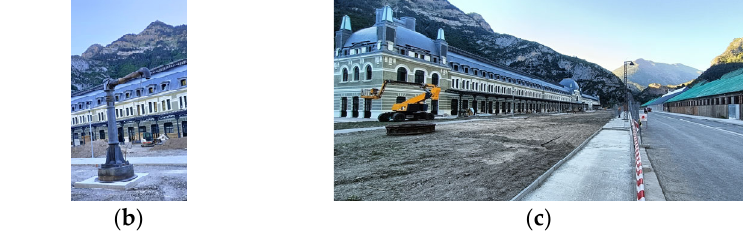
Figure 8. ( a ) View from Canfranc ‐ St. plot (2022). Own Archive. ( b ) View of Canfranc ‐ St. main fa ‐ çade (2022). Own archive. ( c ). View of the historical Canfranc ‐ St. (2022). Own